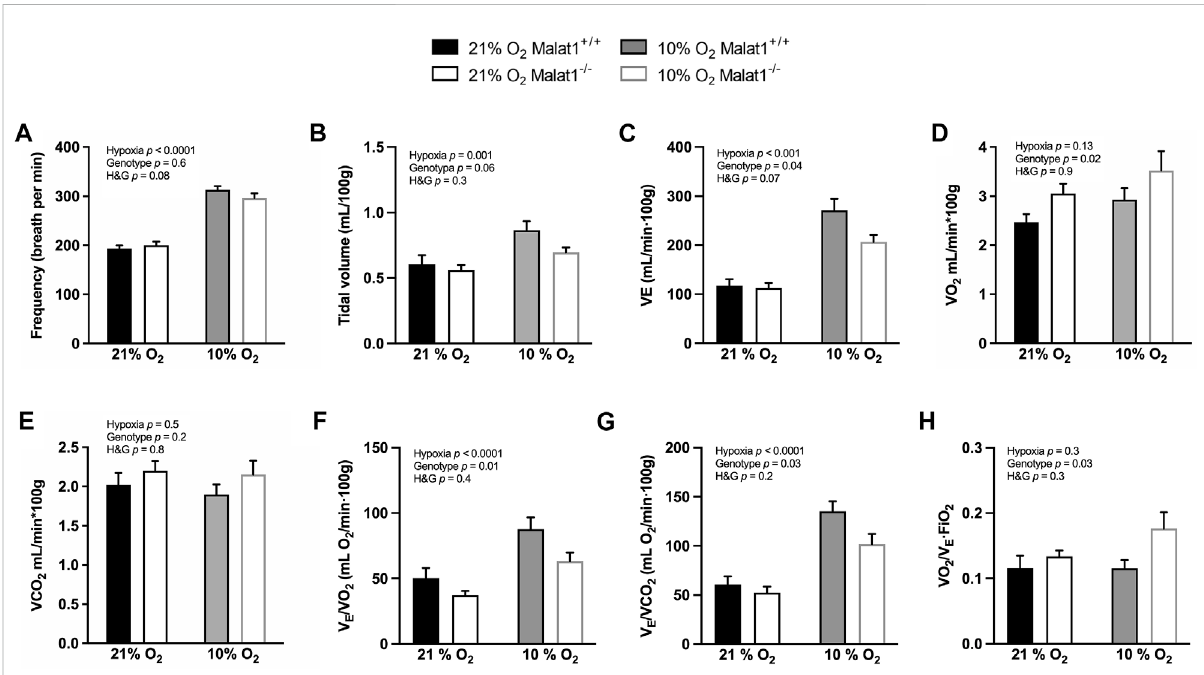
FIGURE 6 Ventilationandoxygenextraction.Malat1 +/+ andMalat1 − / − malemicewererecordedinawhole-bodyplethysmographundernormoxia(21%O 2 ) after 8 days of normoxia (21% O 2 ) or under hypoxia (10% O 2 ) after 8 days of hypoxia (10% O 2 ): The variables measured were: frequency of breathing (A) , tidal volume (B) , minute ventilation (C) , VO 2 (D) , VCO 2 (E) , ventilatory equivalent of oxygen (F) , ventilatory equivalent of carbon dioxide (G) ,